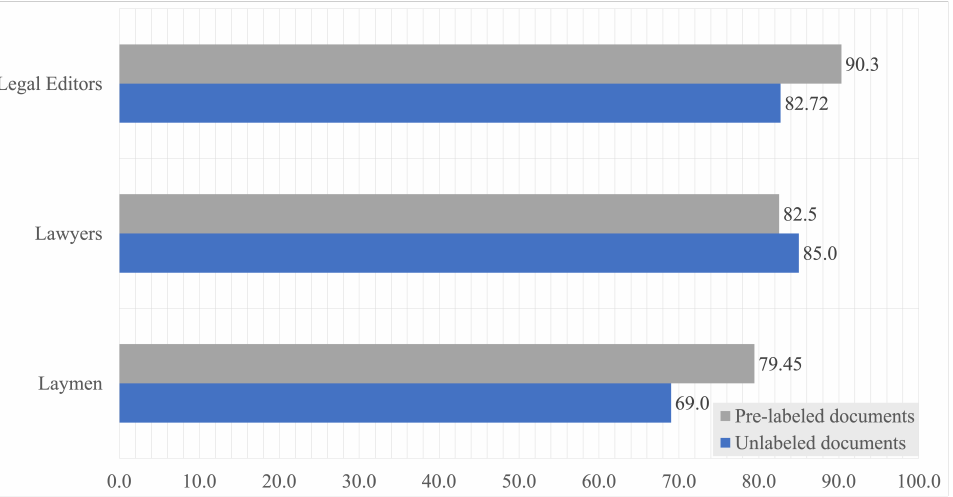
Figure 3. The proportion of at least one correct label found per document partly match plus complete match